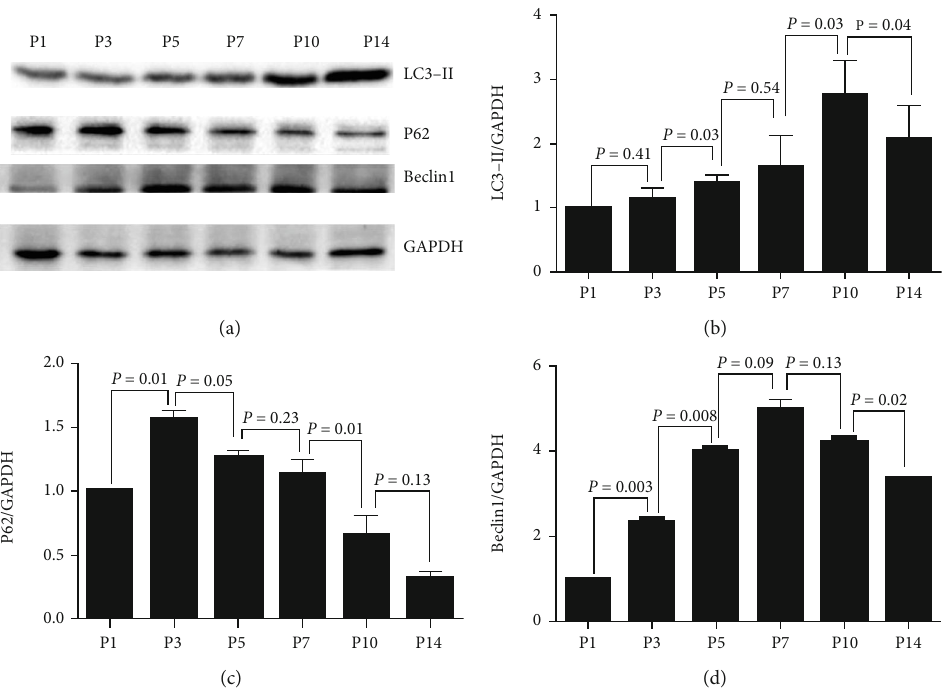
Figure 6: Western blot quantitative analysis for the dynamic change in autophagy machinery proteins. (a) The protein expression levels of LC3-II, P62, Beclin1, and GAPDH were measured by western blotting at di ff erent developmental time points. (b), (c), and (d) show the half quantitative analysis of LC3-II, P62, and Beclin1 expressions, respectively, and it was normalized to that of the GAPDH. Signi fi cant di ff erences were evaluated using repeated measures